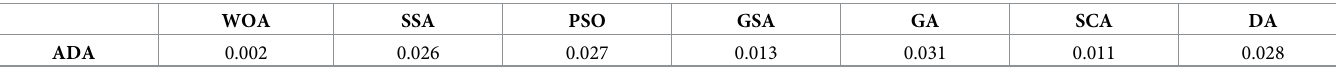
Table 5. p -values of the Wilcoxon rank-sum test in terms of MSE of the proposed method on stock market datasets. WOA SSA PSO GSA GA SCA